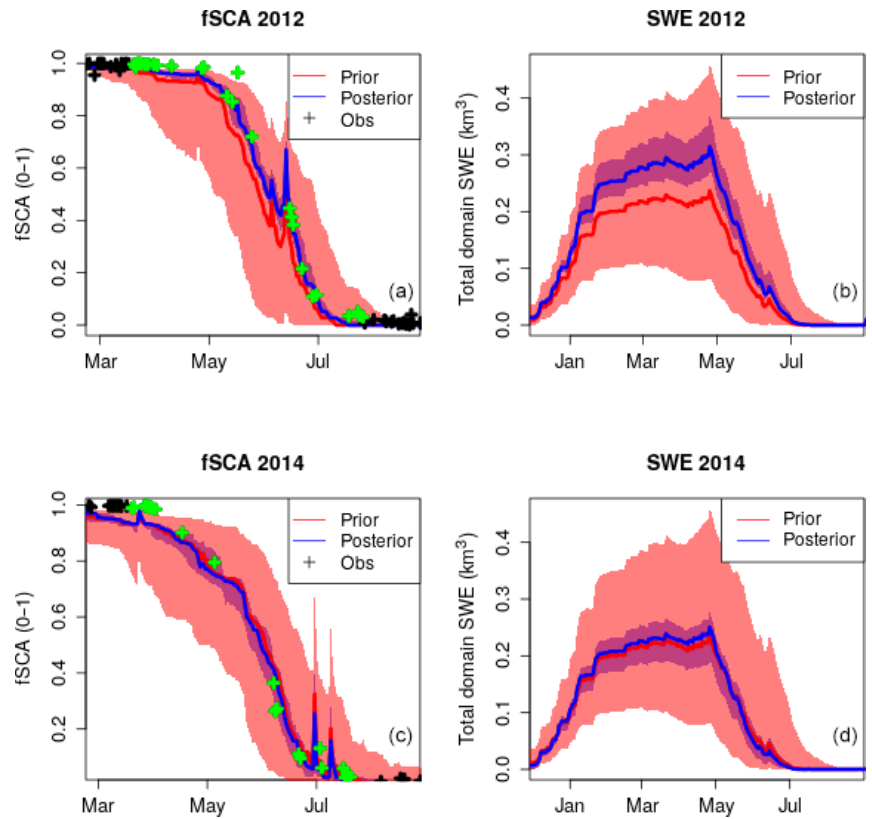
Figure 11. Assimilation of fSCA at the grid level which targets bias in grid-level forcing. Two contrasting seasons, WY2012 (a, b) and WY2014 (c, d) , are shown. The shading and solid lines show the 90th percentile range and median of the prior (red) and posterior (blue) estimates respectively. Assimilated observations are indicated in green. Grid-level biases in WY2012 are compensated for by DA. Grid-level forcing was much more accurate in WY2014 and the resulting effect of DA was